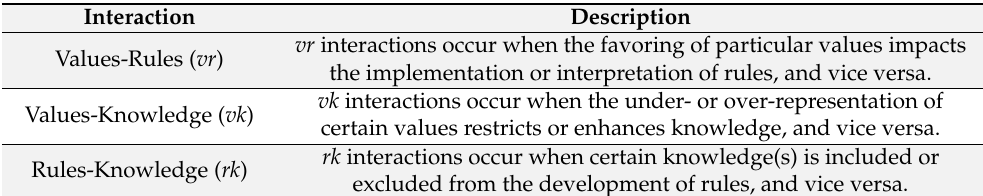
Table 4. Values–rules, values–knowledge, and rules–knowledge interactions (adapted